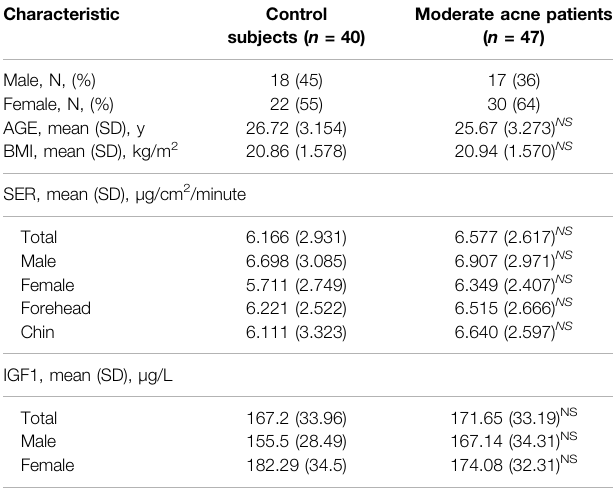
TABLE 1 | Demographic details of control subjects and moderate acne